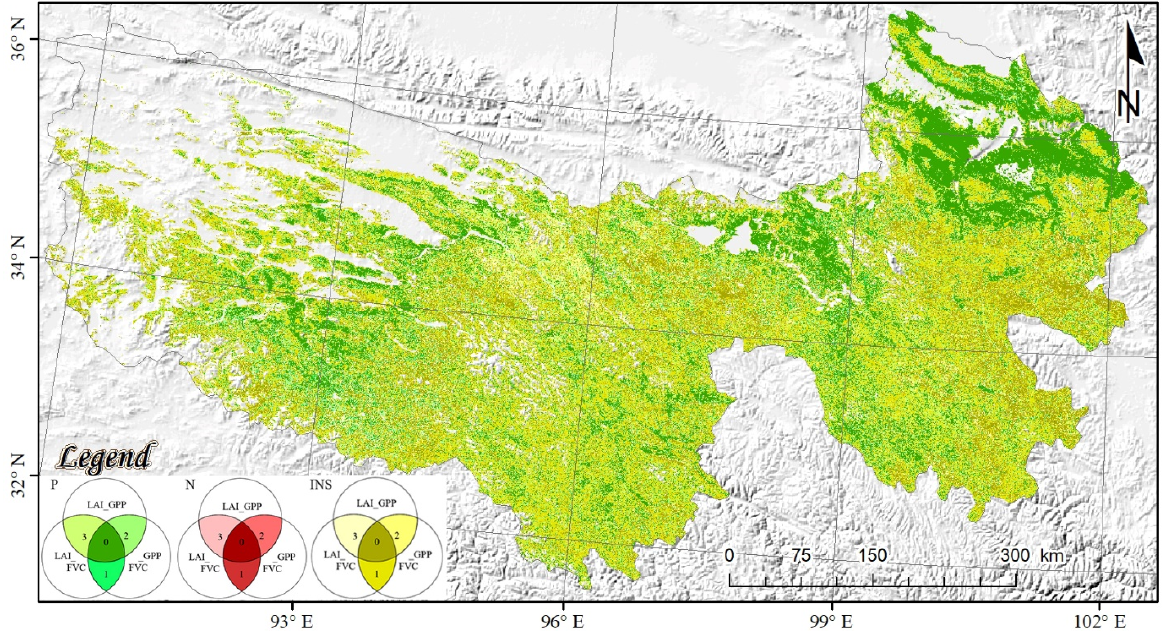
Figure 9. Spatial patterns of long-term correlation comparison calculated by LAI, FVC, and GPP during the 2000–2018 growing season across the TRSR. The dark-colored pixels with ID 0 represent total agreement in the correlation, i.e., total agreement in positive (P0), negative (N0), and insignificant correlation (INS0), while light-colored pixels with ID 1, 2, or 3 represent total disagreement, i.e., total discordant in positive (P1, P2, or P3), negative (N1, N2, or N3), and insignificant correlation (INS1, INS2, or INS3), and the meanings of each ID are shown in Section 2.3.4. Table 4. Comparison statistics of the agreement metrics of interannual variation difference, derived from three products.